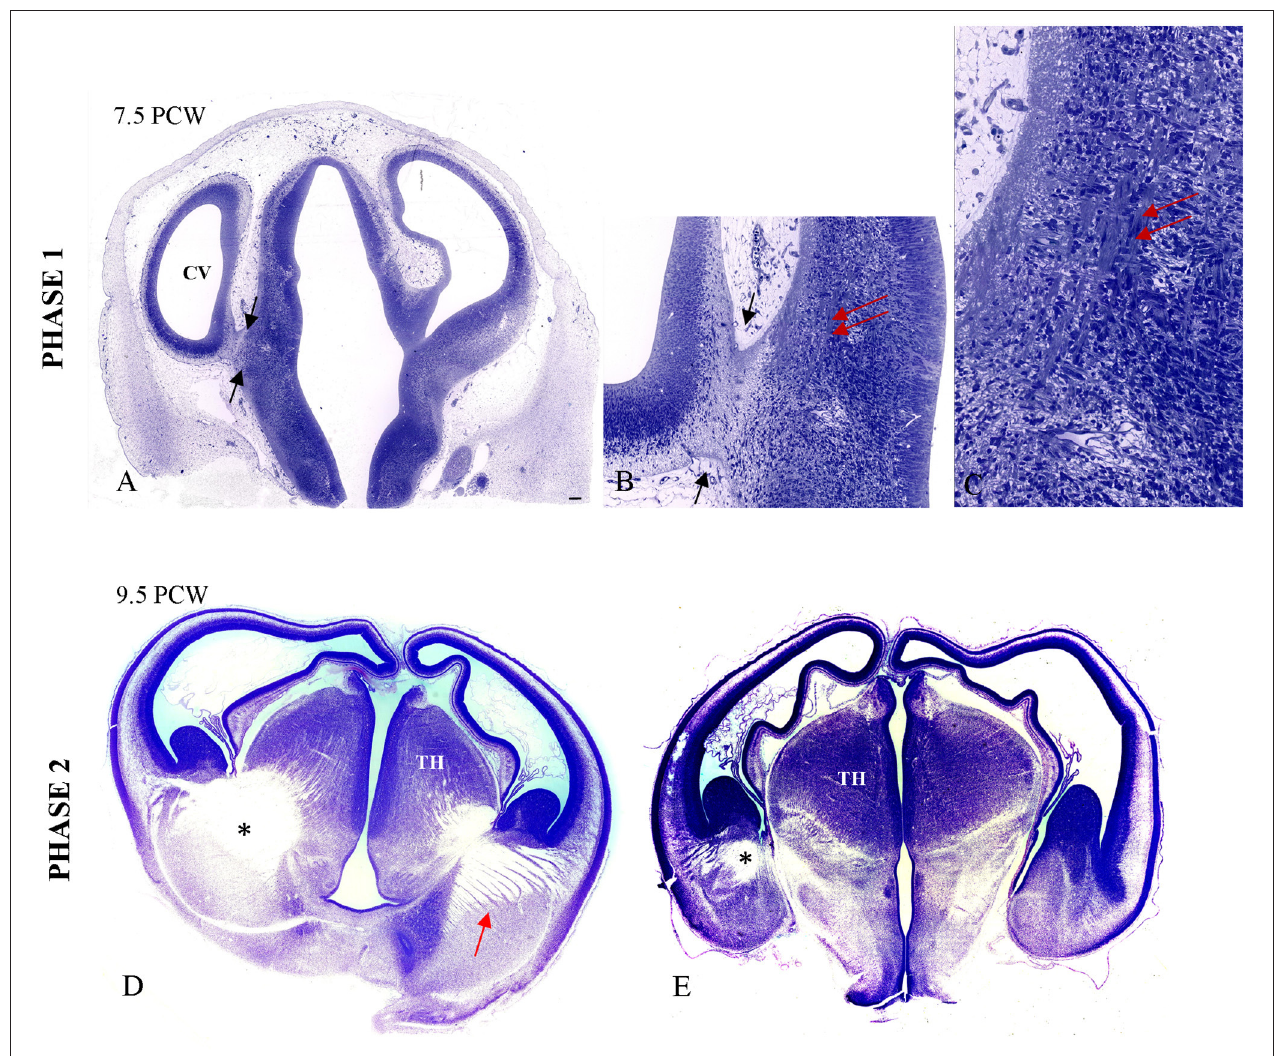
FIGURE 2 | Primitive TH-C stalk at 7.5 PCW (A,B; between arrows). The bundles of the thalamic axons in the ventrolateral aspect of thalamus are visible on high magnification ( B,C; double arrow), on 1 µ m-thick plastic section. The fiber bundles are stained due to osmification of the tissue prepared for electron microscopy. (D,E) The massive TH-C bundle (*) stretching from the ventrolateroposterior aspect of the thalamus, below the diencephalo-telencephalic sulcus and “arriving” below the ganglionic eminence at the pallio-subpallial boundary in the radiating fashion at 9.5 PCW on Nissl-stainedcelloidinsections(arrow).TH,thalamus.Scale bar:100 µ